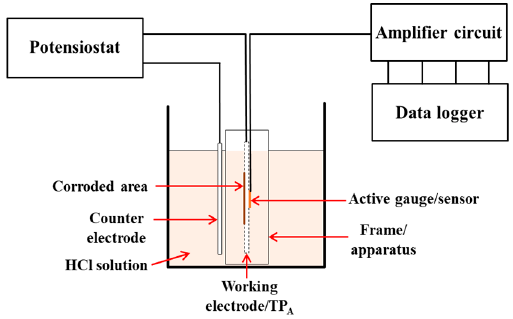
Figure 7. Experimental setup for measuring the thinning of a test piece by galvanostatic electrolysis.